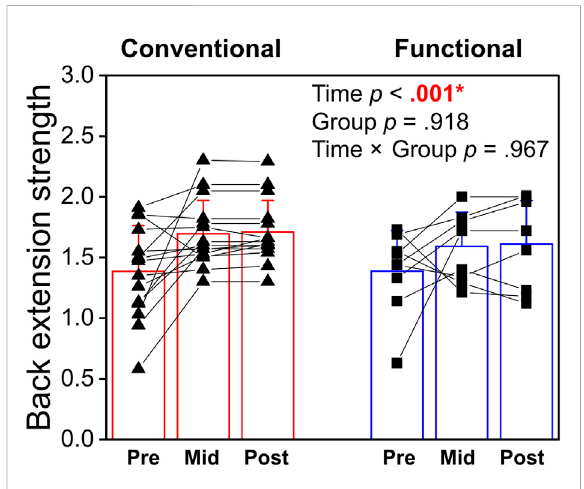
FIGURE 4 Comparison of the normalized isometric back extension strength between the conventional and functional training at pre-, mid- and post-intervention. *Statistical signi fi cance ( p < 0 .05) is shown in red font and indicated by an